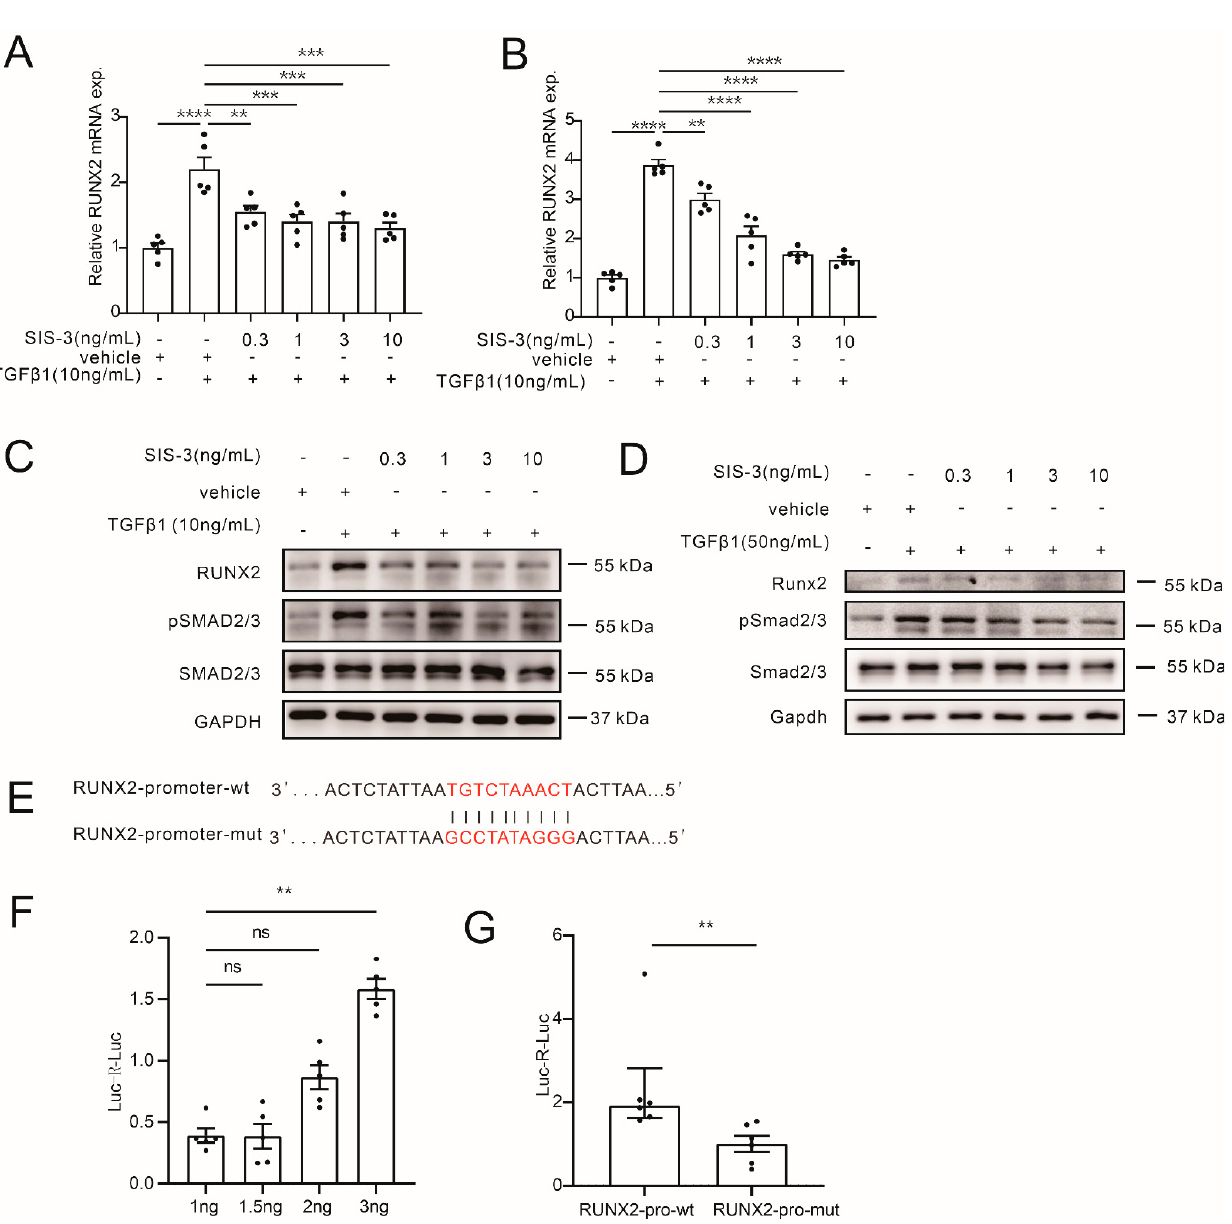
Figure 7. TGFBR1 promotes vascular calcification through the SMAD3/RUNX2 pathway. qRT-PCR results showing that SIS-3 reversed TGF β 1-induced upregulation of RUNX2 levels in HASMCs ( A ) and MOVAS (( B ), one-way ANOVA, n = 5). Western blot images showing that different doses of SMAD3 inhibitor SIS-3 alleviated TGF β 1-induced RUNX2 level increase and SMAD2/3 phosphory- lation in HAMSCs ( C ) and MOVAS ( D ). ( E ) The JASPAR database predicted the binding site of SMAD3 on RUNX2 promoter, and the mutation was generated. ( F ) HASMCs were transfected with Renilla plasmid, wildtype RUNX2-promoter luciferase plasmid, and different doses of SMAD3-OE plasmid for 24 h, and luciferase activity was detected (one-way ANOVA, n = 5). ( G ) HASMC was transfected with Renilla plasmid, SMAD3-OE plasmid (3 ng per well of 12-well plate), and wildtype (wt) or mutated (mut) RUNX2-promoter luciferase plasmid, and luciferase activity was detected (Mann–Whitney test, n = 6).** p < 0.01, *** p < 0.001, **** p < 0.0001, n.s. not significant.